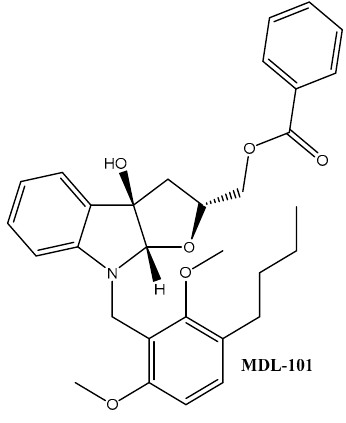
Figure 7. MDL-101 derivative of madindoline.